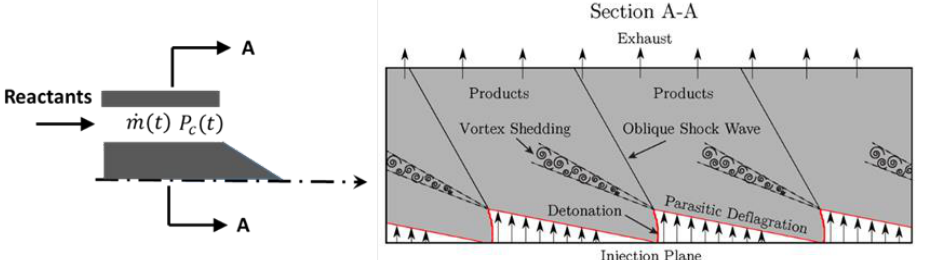
Figure 1. Topology of annular RDE combustor with time-dependent massflow and chamber pressure. Section A-A shows notional reactant fill region and shock/detonation wave structures with multiple waves present around the combustor annulus.